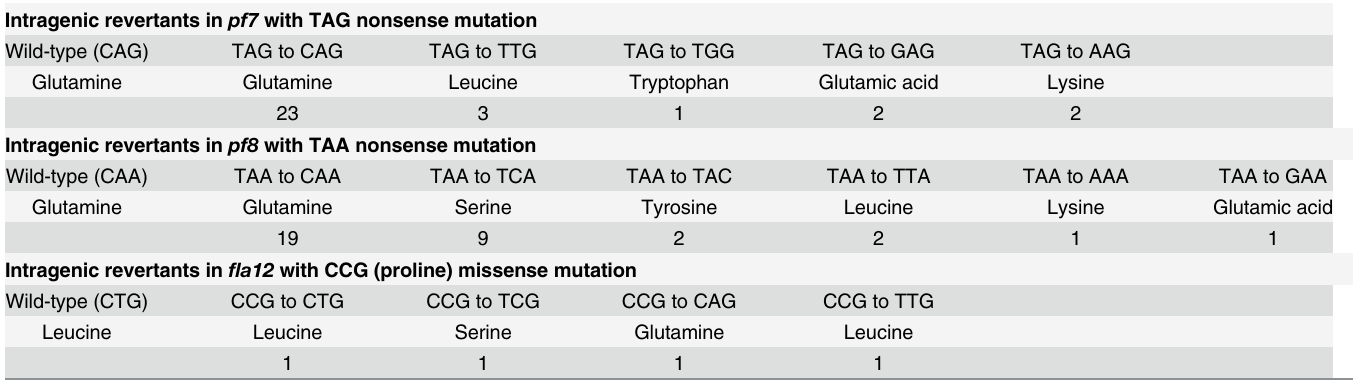
Table 3. Reversion of pf7 , pf8 , and fla12 mutations.